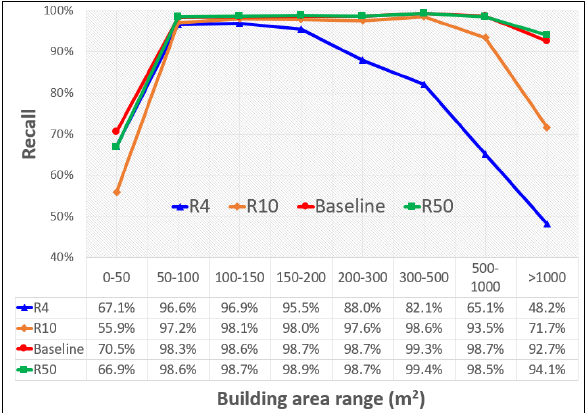
Figure 4 . Effect of building area on recall.